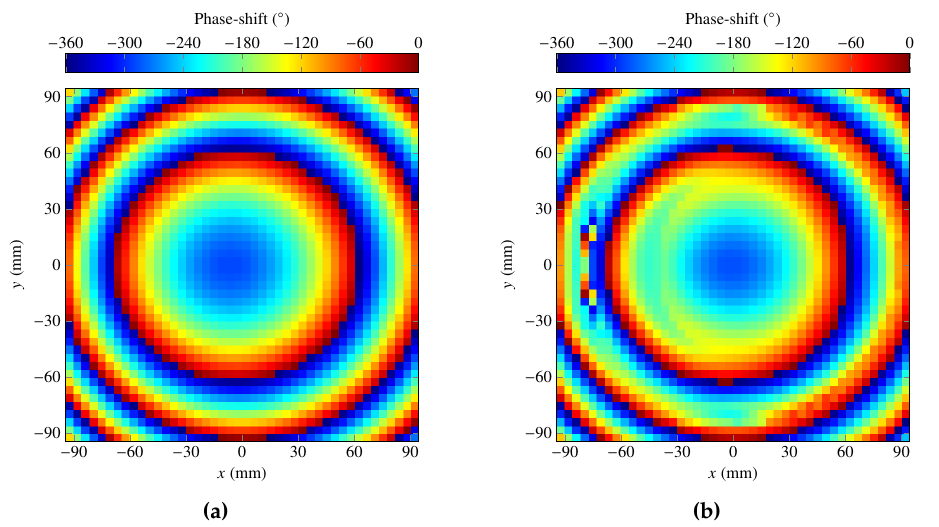
Figure 5. ( a ) Initial phase-shift distribution of a far-field-focused reflectarray at 28GHz. ( b ) Optimized phase-shift distribution after the POS with the GIA at 28GHz.